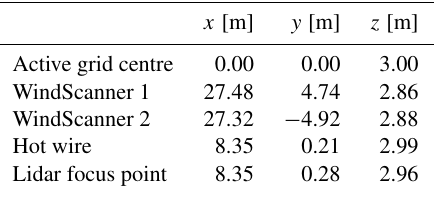
Table 1. Coordinates relevant to the experimental setup.